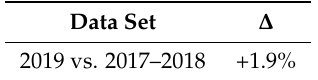
Table 4. Estimate of the performance change before and after gearbox replacement. (below rated power).